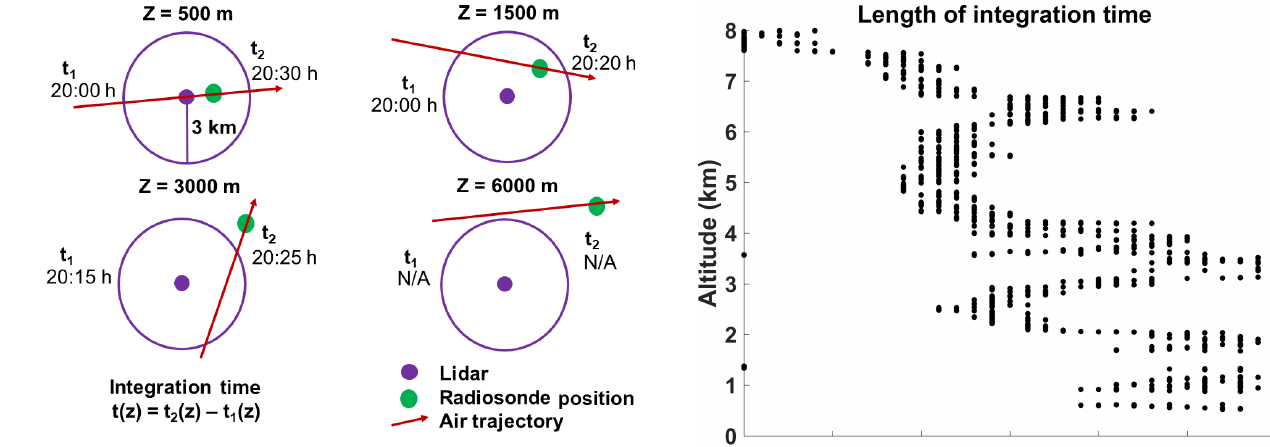
Figure 1. Trajectory calculation and scan selection hypothetical ex- ample. The purple circle around the lidar has a 3km radius and rep- resents the region in which we assume the humidity field is hor- izontally homogeneous. The green dot is the radiosonde position, the purple dot is the lidar position, and the red arrow is the air par- cel trajectory. The variable z refers to altitude, t 1 is the entry time, and t 2 is the exit time from the 3km radius. The integration time, t(z) , is the total time that the air parcel spends inside the homoge- neous region. When the air parcel trajectory does not intersect with the circle, then no data are available for calibration.